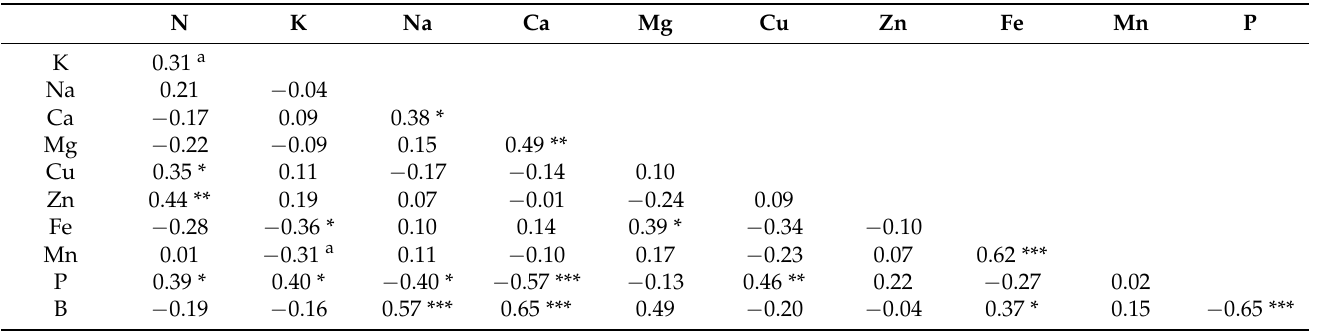
Table 4. Pearson correlation matrix with respective r values between above-ground biomass concen- trations of the studied macro- and micro-nutrients of the wild-growing Greek tulip species.